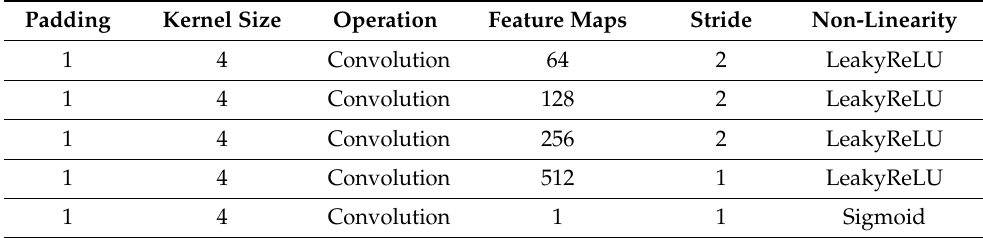
Table 4. Discriminator